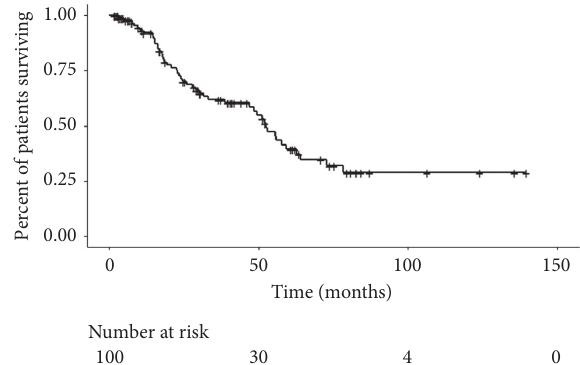
Figure 1: Overall survival. Median overall survival was 52.4 months (95% CI: 46.9–64.0 months) after ablation of sarcoma metastases.